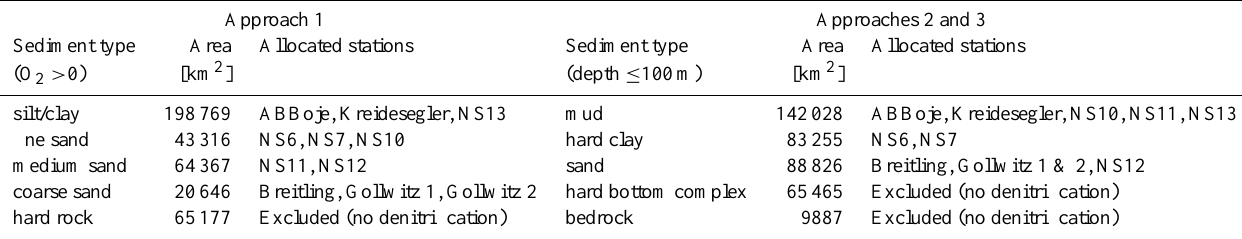
Table 1. Allocation of the sampled stations to various sediment types of the respective sediment map.